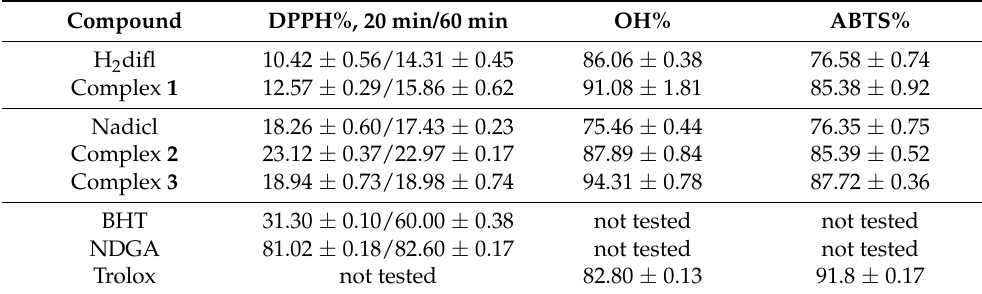
Table 6. % DPPH scavenging ability (DPPH%), % ABTS radical scavenging activity (ABTS%), competition % with DMSO for hydroxyl radical (OH%) for diflunisal, sodium diclofenac, and their complexes 1 – 3